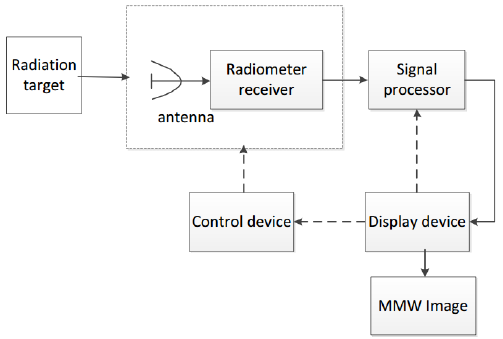
Figure 1. Schematic of passive millimeter